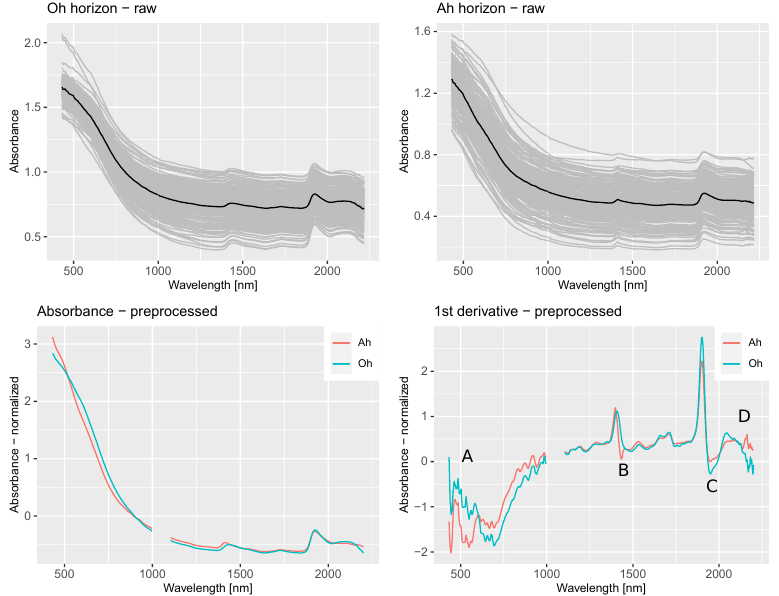
Figure 5. Raw spectra (black line represents the mean) and preprocessed absorbance and 1st derivative spectra of samples from Oh and Ah samples, ranges with remarkable differences are marked by letters A–D. Table 4. Model results for selected soil properties and algorithms for Oh (left) and Ah (right) samples from